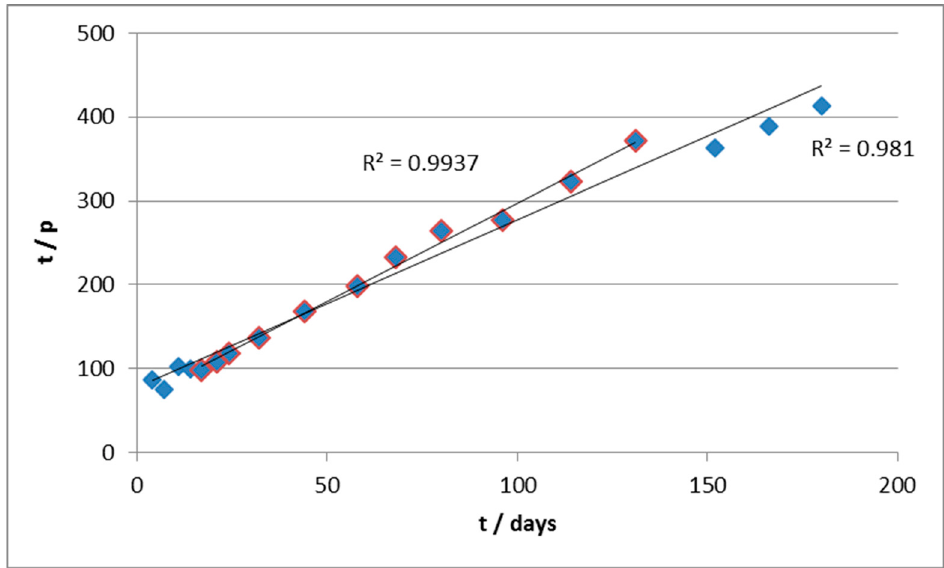
Figure 6. Regression of the curve of conversion of material C according to the Wilkinson model. Last three points included or not included in the regression.